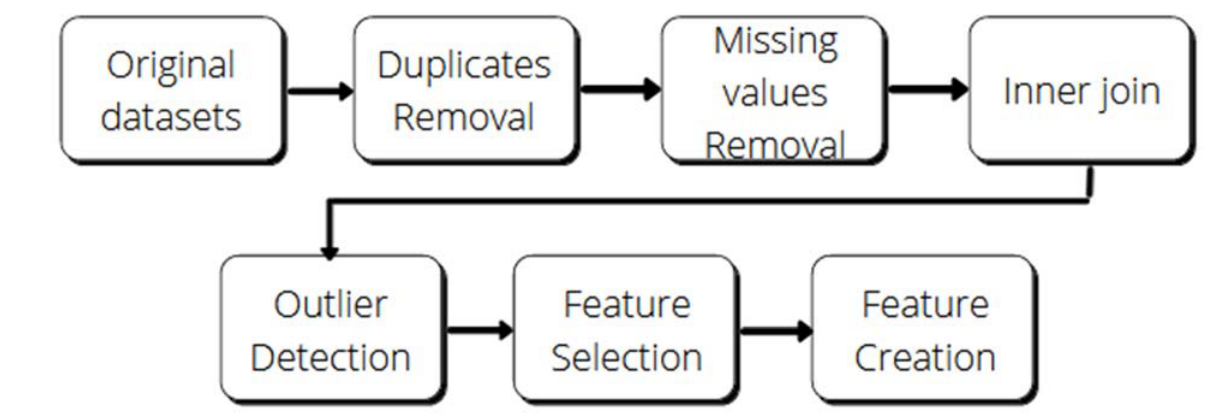
Figure 4. Adopted data pre-processing scheme.